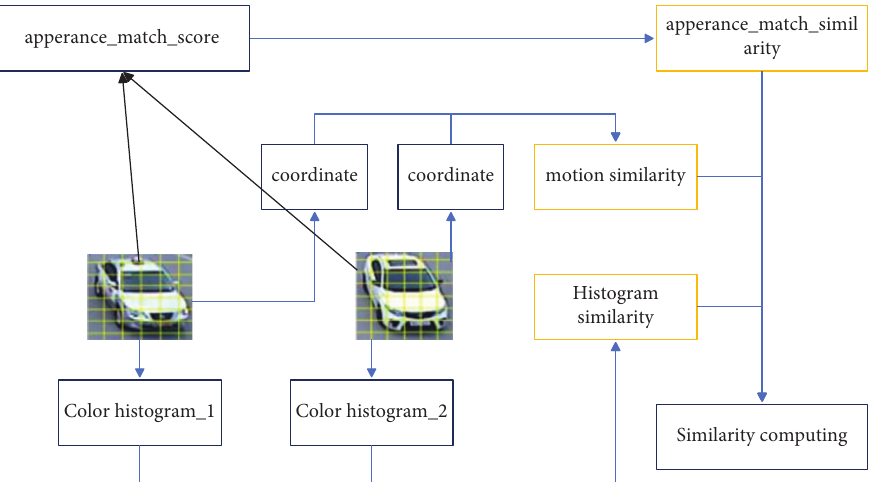
Figure 3: The matching features in the tracking process.